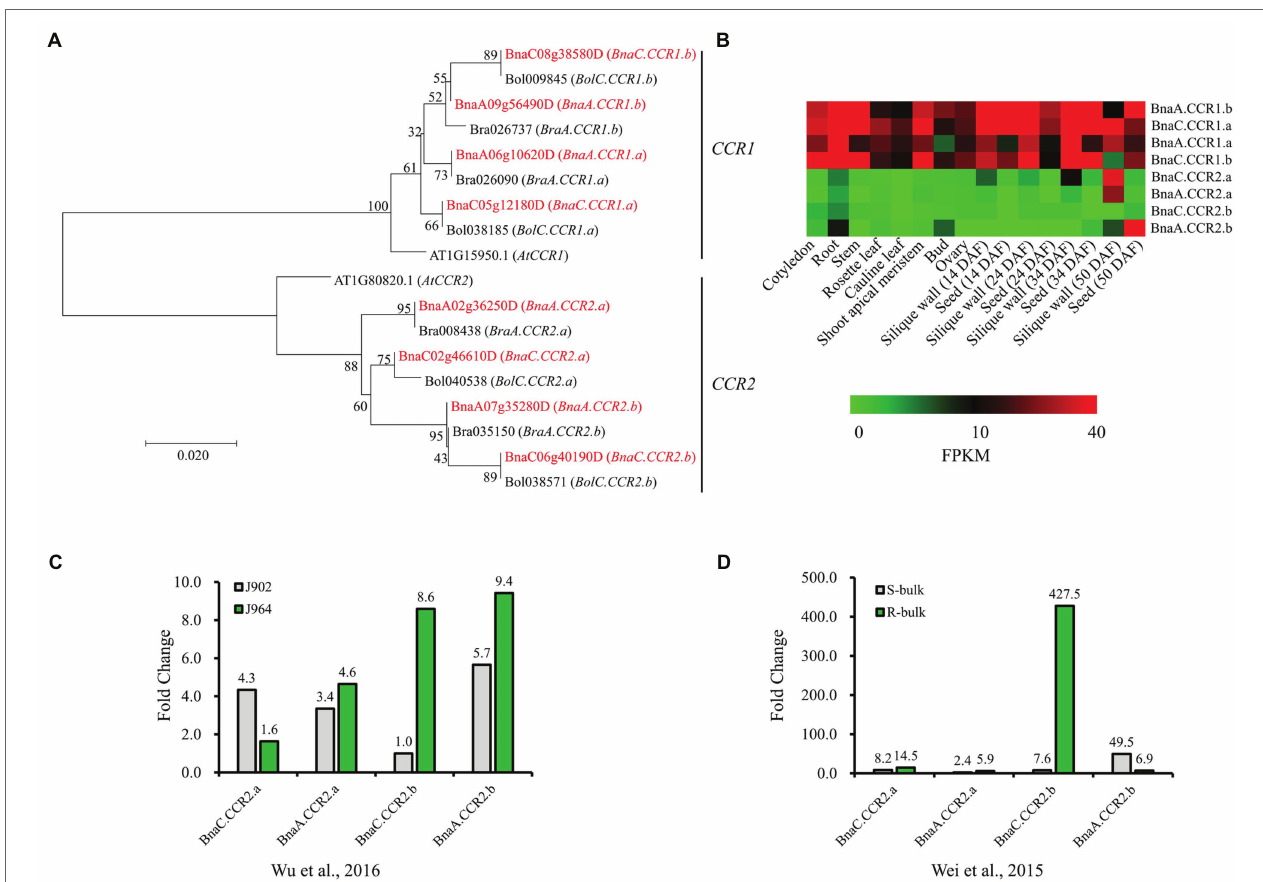
FIGURE 2 | Phylogenetic and expression analyses of BnCCR genes. (A) Phylogenetic relationships of CCR genes from Brassica napus , Brassica rapa , Brassica oleracea , and A. thaliana. The red color indicates genes from B. napus . Bootstrap values (1,000 replications) are shown at each branch as percentages. A branch length scale bar is shown beneath the tree. (B) Expression patterns of BnCCR genes in various tissues of B. napus line J9712, as determined by transcriptome sequencing. FPKM, fragments per kilobase of transcript per million fragments mapped. DAF, days after flowering. (C,D) Expression patterns of BnCCR genes in the stems of B. napus at 48 h after Sclerotinia sclerotiorum infection. The fold changes (inoculated/mock inoculated) were calculated through transcriptomic analyses performed by Wu et al. (2016) and Wei et al. (2015). J964: a resistant line. J902: a susceptible line. R- and S-bulk: mixed pools of resistant and susceptible lines,